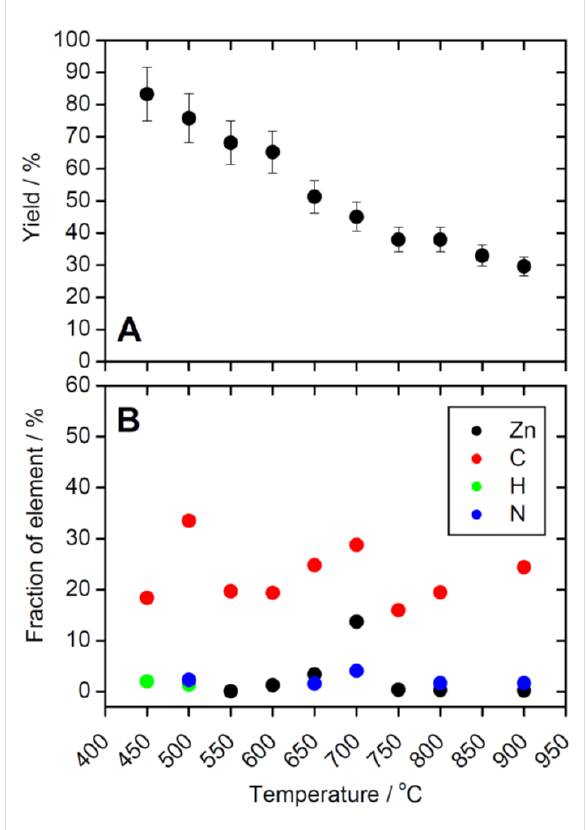
Figure 2: (A) Yield vs reaction temperature. (B) Chemical composition data from elemental analysis (EA) and energy dispersive X-ray spec- troscopy (EDXS): Zn, C, H, and N fractions vs temperature. No symbol in (B) indicates that the concentrations of the respective elements are below the limit of detection of the respective instrument (EA = 0.3%, EDXS =